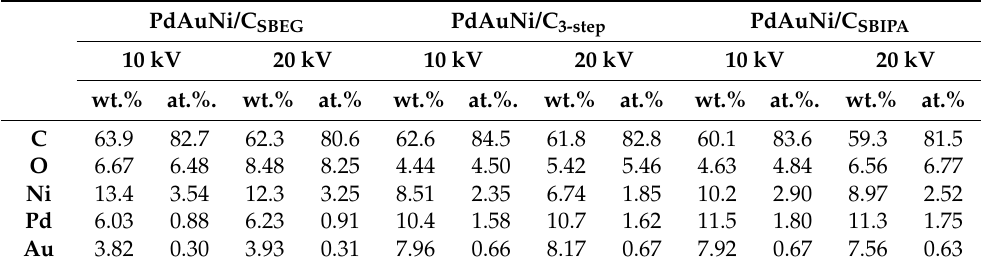
Table 3. Quantitative EDX analysis of PdAuNi/C SBEG , PdAuNi/C 3-step , and PdAuNi/C SBIPA at 10 kV and 20